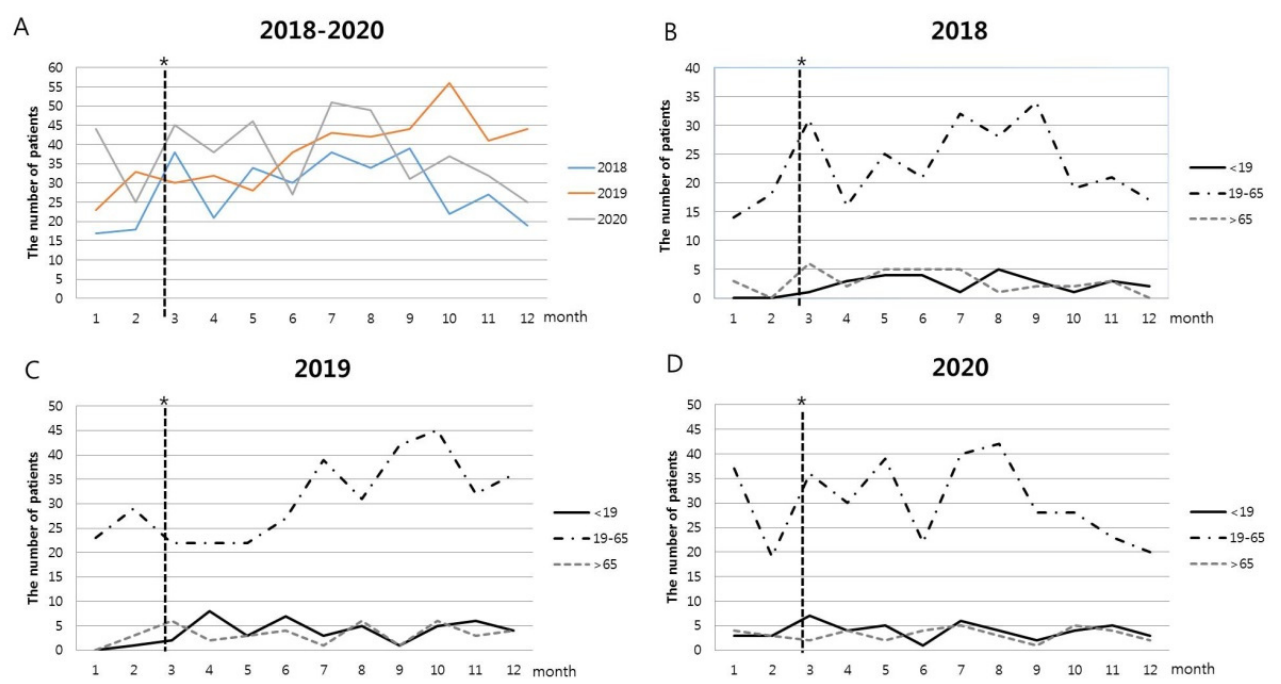
Figure 2. Trends in the number of suicide attempts by year. ( A ) Number of suicide attempts by year for all ages, ( B ) Number of suicide attempts by age in 2018, ( C ) Number of suicide attempts by age in 2019, ( D ) Number of suicide attempts by age in 2020. * The dotted line means that on 23 February 2020, the infectious disease crisis level was raised to red.